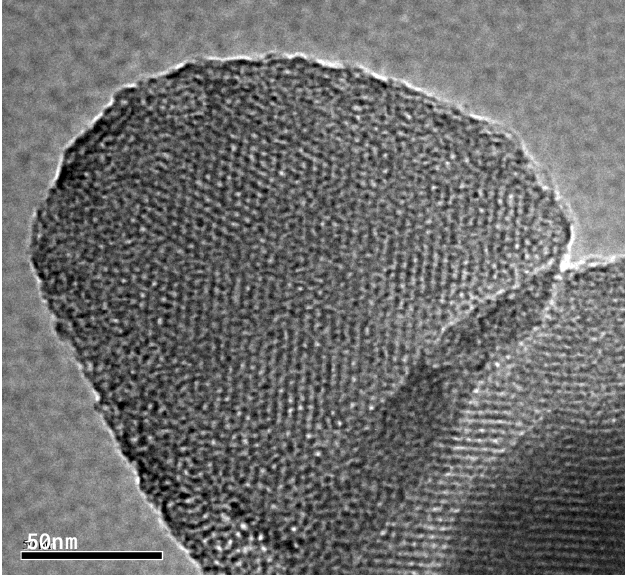
Figure 4. Transmission electron micrographs of dye-impregnated